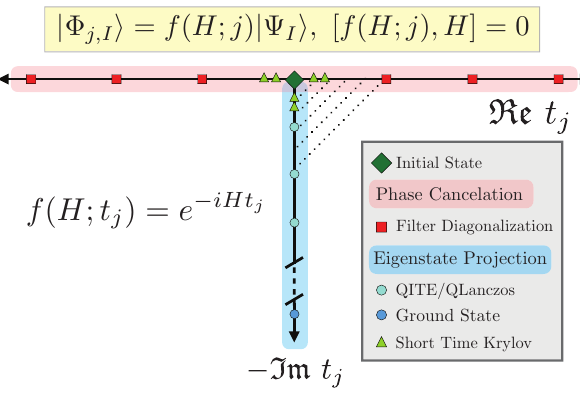
FIG. 7. A schematic picture of recent eigenvalue algorithms relying on time evolution proposed for quantum computers. The plane corresponds to the complex time plane, with the horizon- tal axis being real time and the vertical axis imaginary time. The colored dots denote expansion states | φ j , I (cid:3) . The operator f ( H ; j ) denotes any unitary that commutes with the Hamiltonian, and thus the expansion states formed by applying this unitary will remain in the support space and can be used to extract eigenstates. The real-time axis is where the phase cancelation picture applies. On the imaginary-time axis, the coefficients of the excited states are suppressed as time increases, leading to the ground state. The dotted lines indicate that short time imaginary- and real-time states will be very similar, as argued in the short time Krylov method [51]. We emphasize that combinations of states generated on the entire real- or imaginary-time plane have essentially the same support space and can be used as a basis to solve the generalized eigenvalue